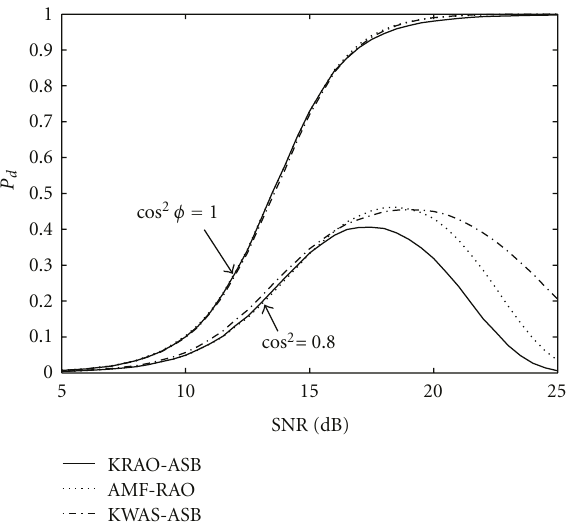
Figure 9: P d versus SNR for the KRAO-ASB with ρ = 1 . 2, the KWAS-ASB with γ = 1 . 1, and the AMF-RAO, N = 16, K = 32.